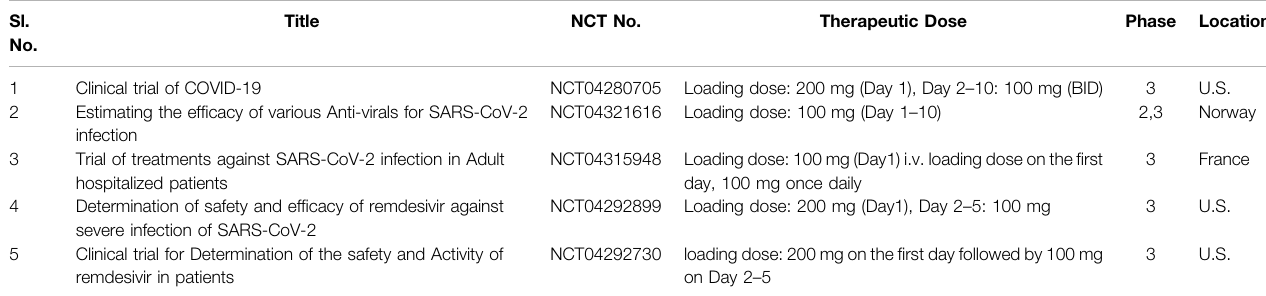
Clinical trial for Determination of the safety and Activity of remdesivir in